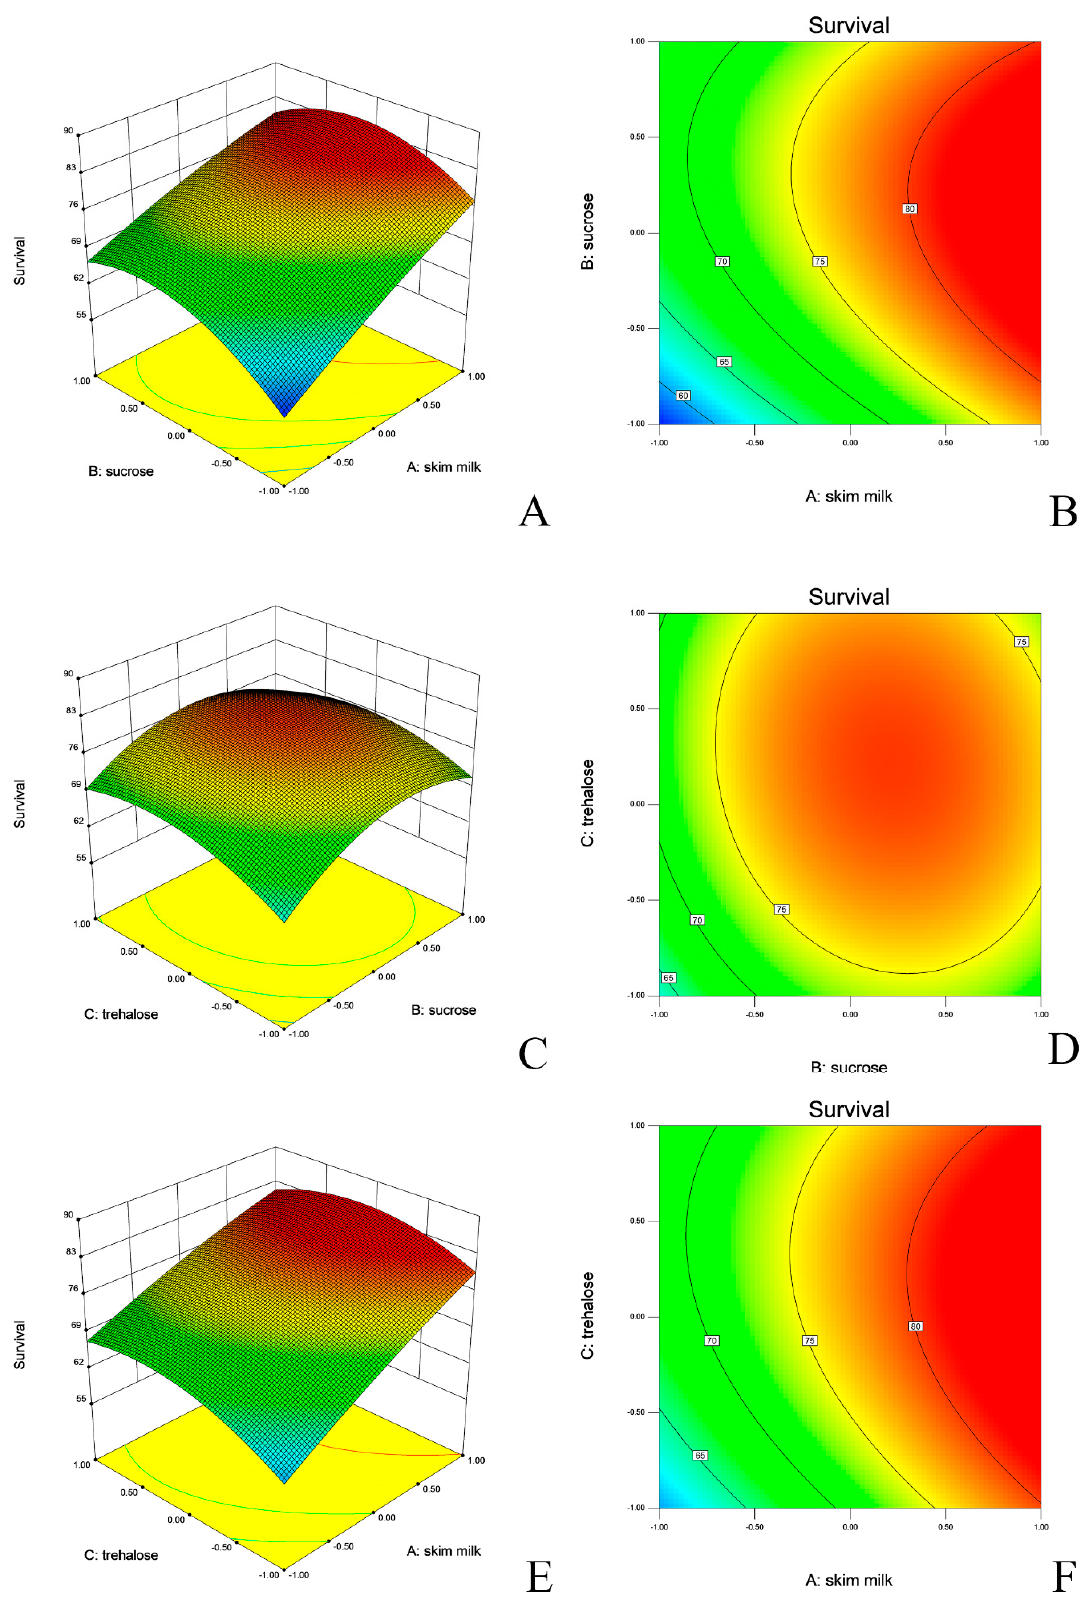
Figure 3. Response surface and contour plots depicting L. agilis viability after lyophilization. ( A , B ): skim milk vs. sucrose. ( C , D ): sucrose vs. trehalose. ( E , F ): skim milk vs. trehalose.